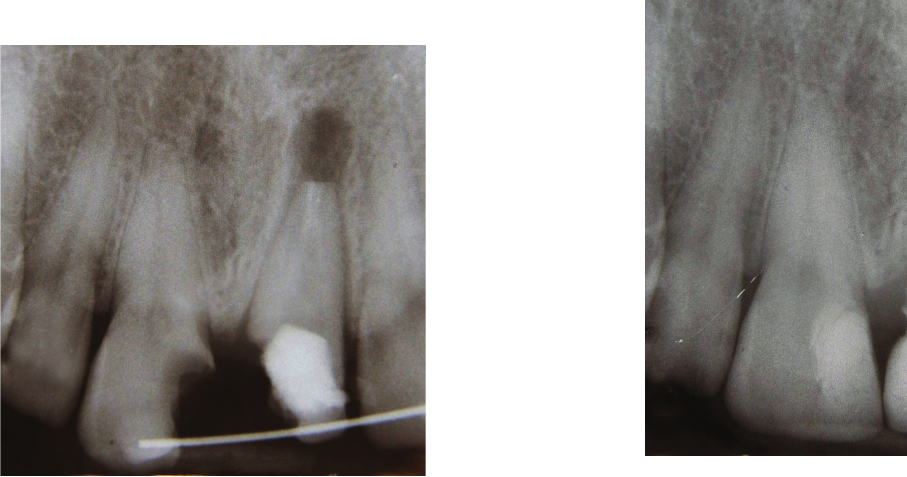
Figure 8: 12 months after intentional replantation; periapical radiolucency was noticeably